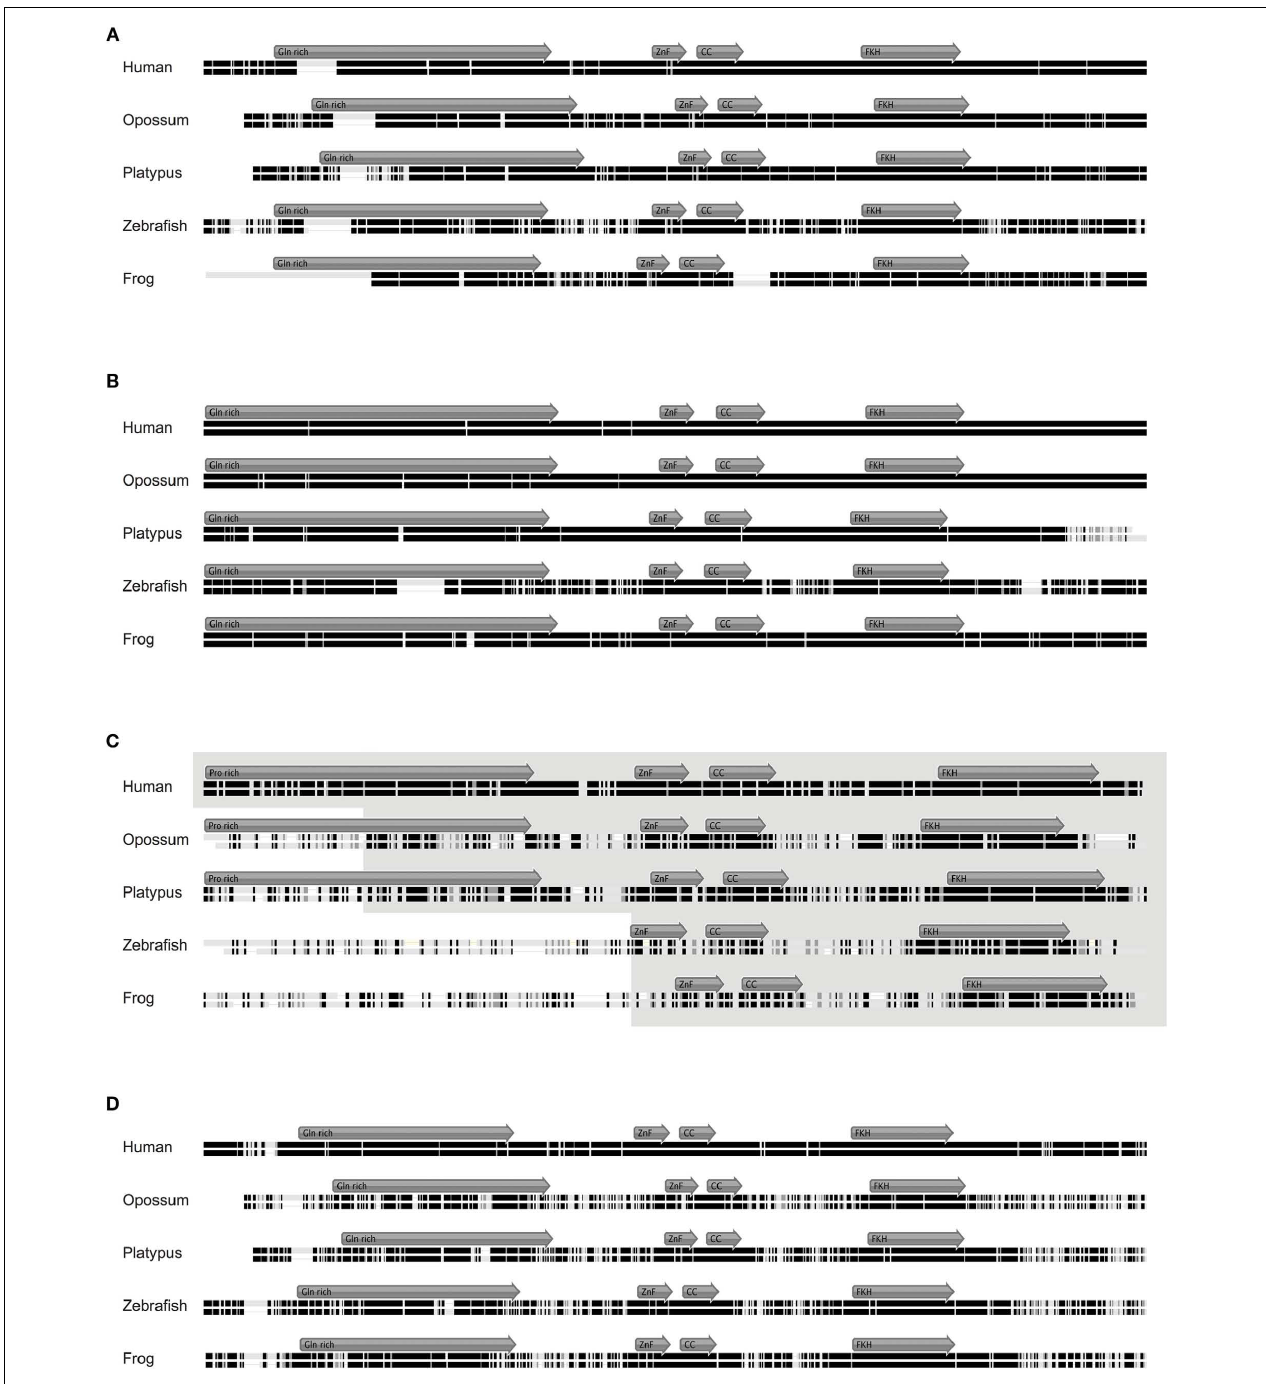
platypus (55.5% identity; 502aa), frog (34.5% identity; 593aa), and zebrafish (30.1% identity; 376aa). (D) Mouse Foxp4 protein sequence aligned to its putative orthologs in human (92.3% identity; 680aa), opossum (55.7% identity; 677aa), platypus (69.7% identity; 670aa), frog (70.8% identity; 641aa), and zebrafish (69.7% identity; 670aa).The gray arrows show the position of the putative functional domains within the aligned sequence. Identical amino acids are represented by black bars, similar amino acids by gray bars, and not similar amino acids by white bars. Gaps are shown as black